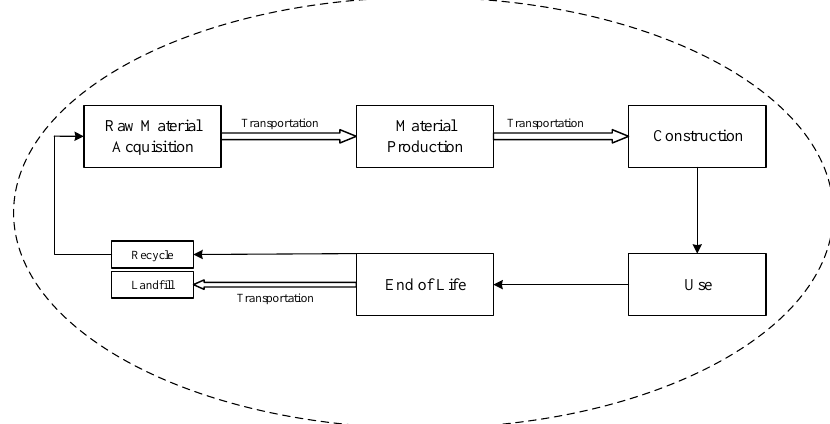
Figure 4. System boundary for LCC.